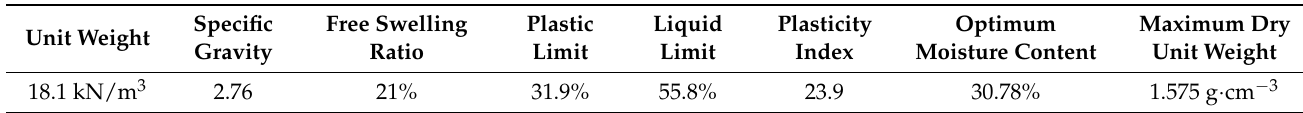
Table 1. Basic physical and mechanical properties.